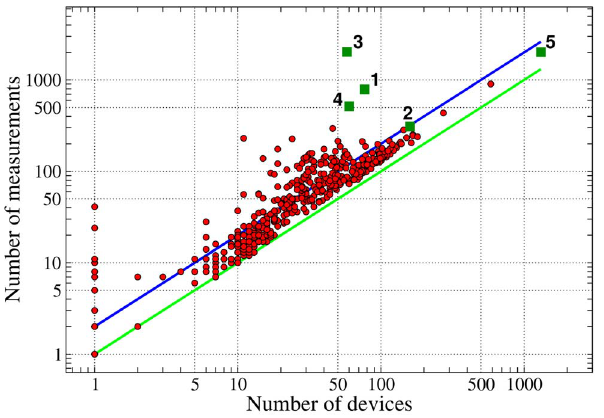
Figure 6. Measurements versus devices. Scatter plot of the number of measurements collected each day compared to the number of active devices at that day. The dark green symbols correspond to the most important spikes shown also in Figure 5. The green and blue lines are guides for the eye and correspond to the case of one measure per device and two measures per device respectively.